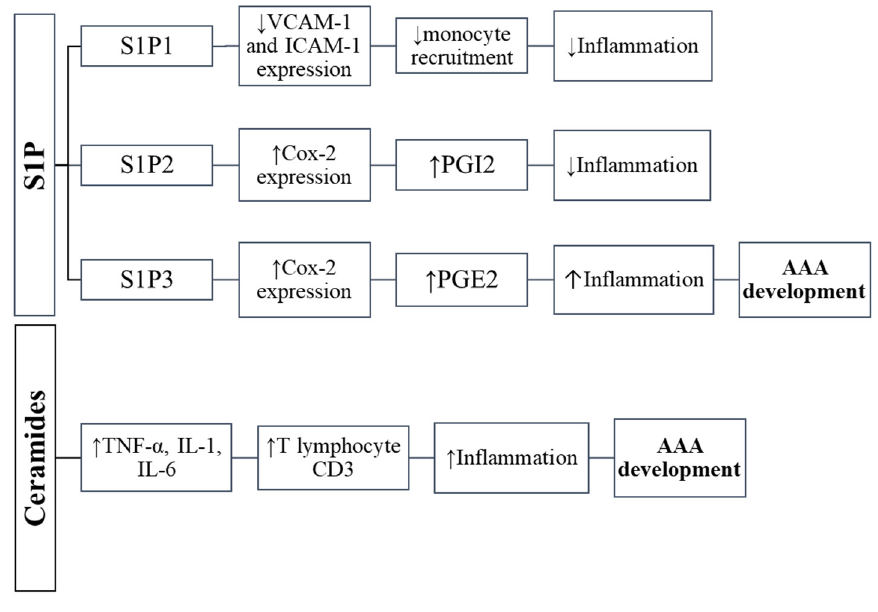
Figure 2. The influence of sphingolipids on inflammation in abdominal aortic